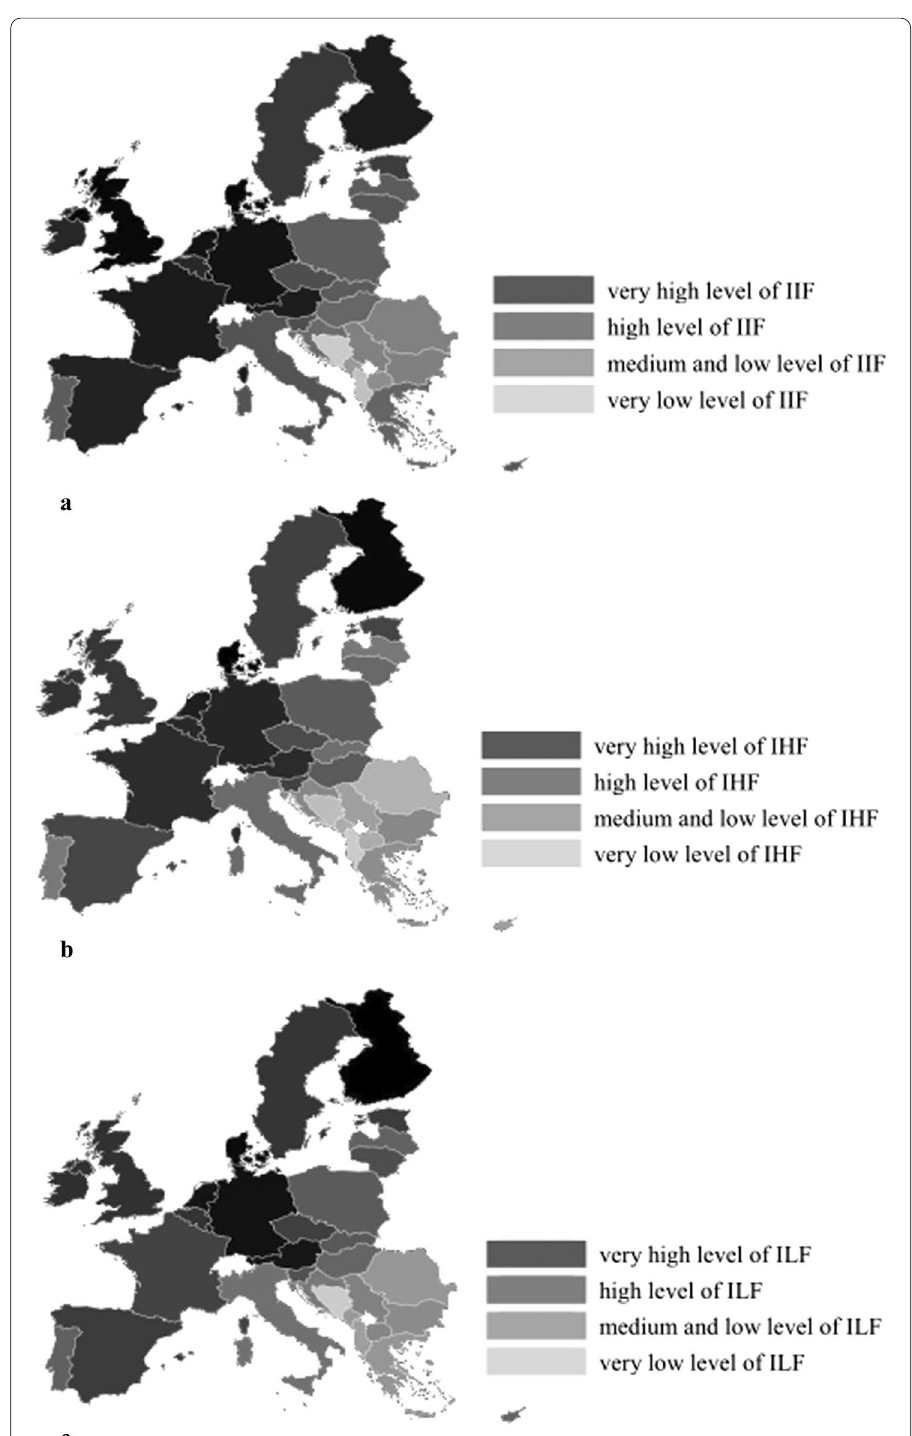
Fig. 4 a Division of EU countries into typological groups according to institutional factors. b Division of EU countries into typological groups according to human factors. c Division of EU countries into typological groups according to linkage factors. d Division of EU countries into typological groups according to framework factors. e Division of EU countries into typological groups according to intangible output